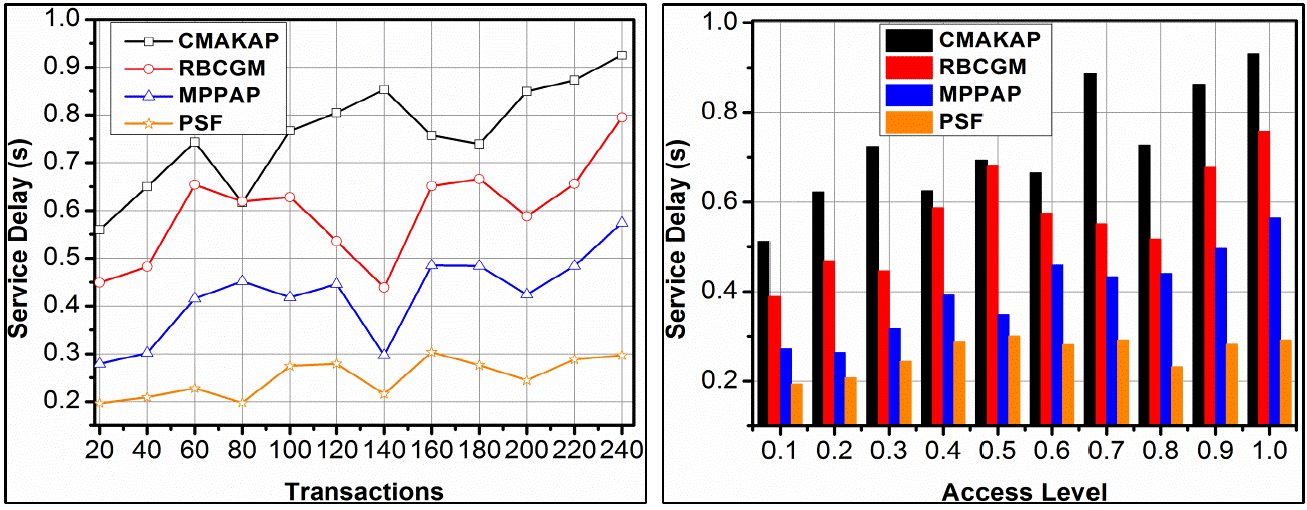
Figure 9. Service delay analysis.